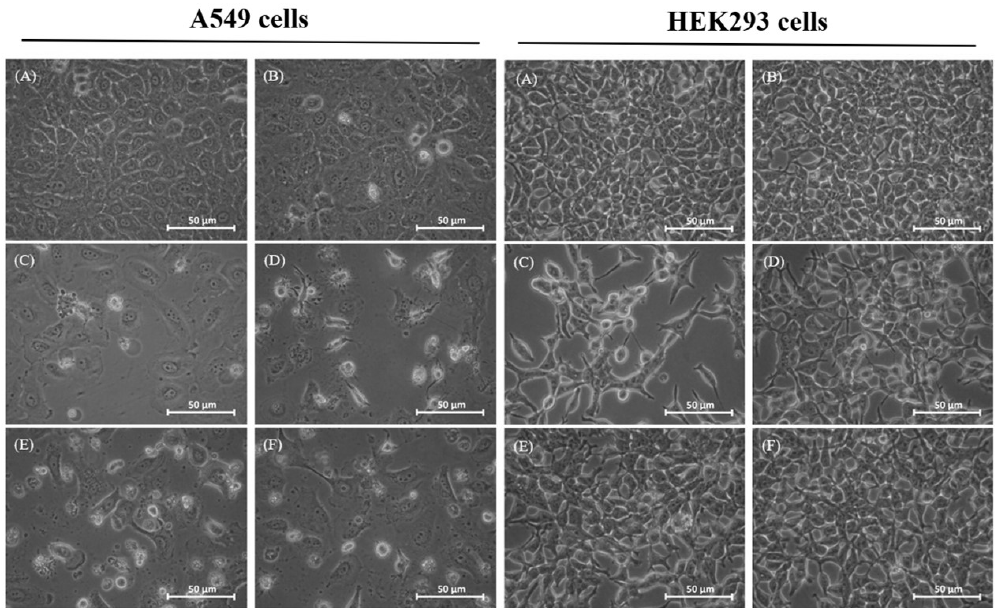
Figure 1. Morphology of DDP- and OGA-treated human lung cancer A549 cells and normal human embryonic kidney HEK293 cells. ( A ) Control, ( B ) OGA 24 h, ( C ) DDP 24 h, ( D ) DDP + OGA 24 h, ( E ) DDP 12 h + OGA 12 h, ( F ) OGA 12 h + DDP 12 h. Control: untreated A549 cells, DDP: cisplatin (2 μg/mL), OGA: oligogalacturonides (100 μg/mL). Int. J. Mol. Sci. 2018 , 19 , x FOR PEER REVIEW